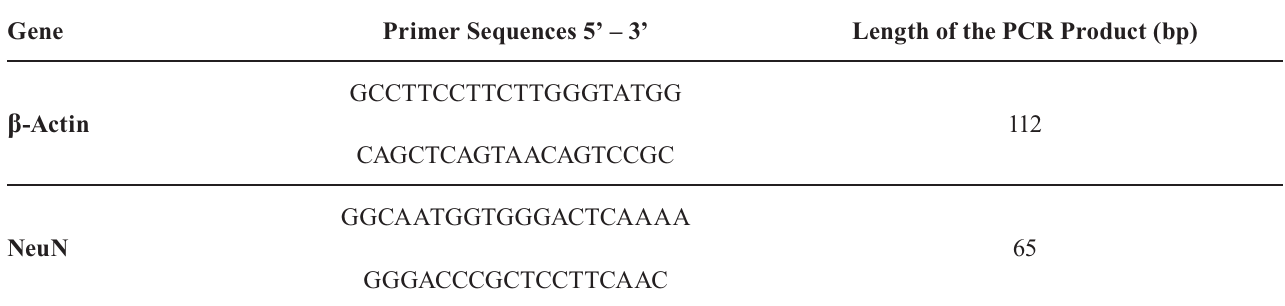
TABLE I - F orward and reverse primer sequences used for the expression analysis of b -Actin, NeuN, Ki67 and DCX